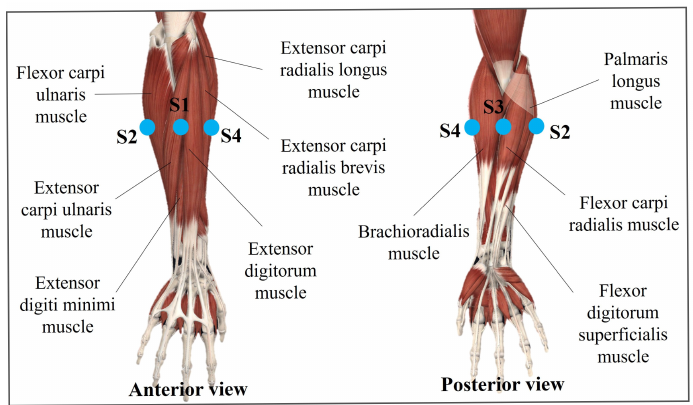
Figure 6. Location of the sEMG sensors in the